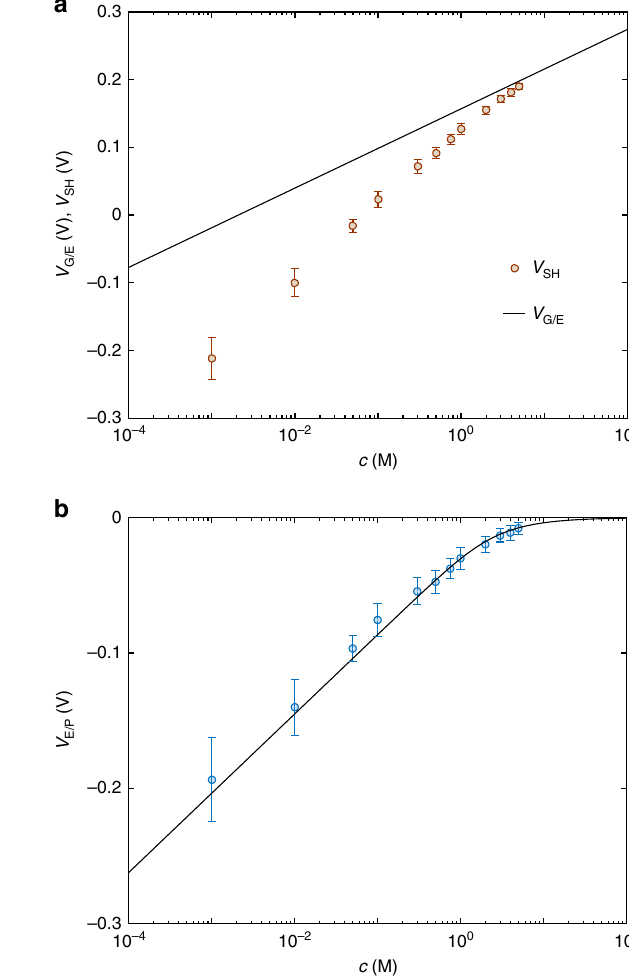
Fig. 2 OECT parameters as a function of the ion concentration. a Normalized conductivity Γ n = Γ L W − 1 t − 1 as a function of the ion concentration. b Threshold voltage V T as a function of the ion concentration. Circles are the mean value and error bars are the standard deviation calculated by modeling ten OECTs with various thicknesses